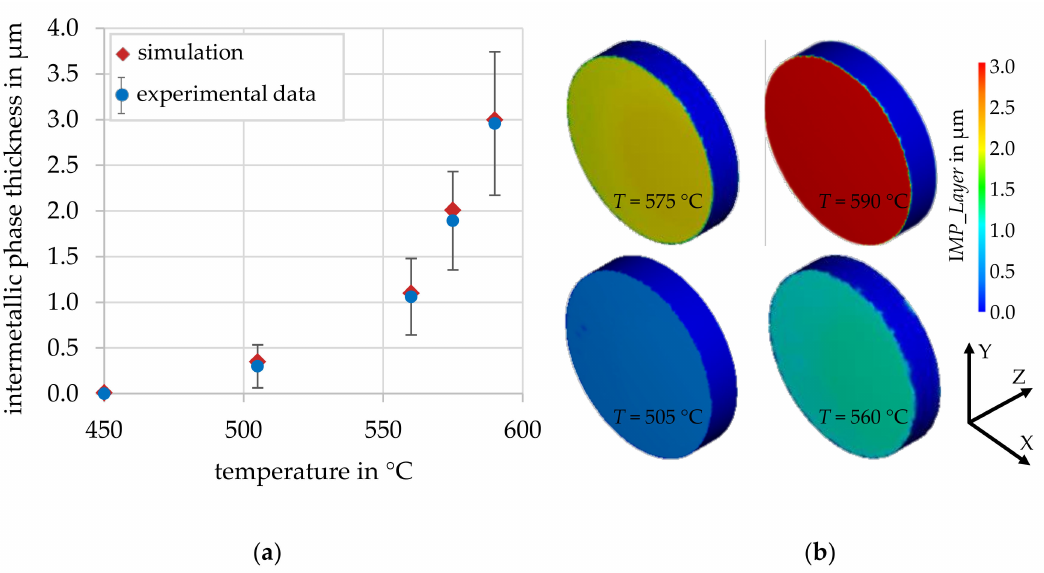
Figure 14. ( a ) Comparison of the experimentally determined intermetallic phase seam thickness with the simulated phase seam thickness of the respective forming temperature for a forming time of 120 s and a force of 5890 N, ( b ) simulated thickness of the intermetallic phase